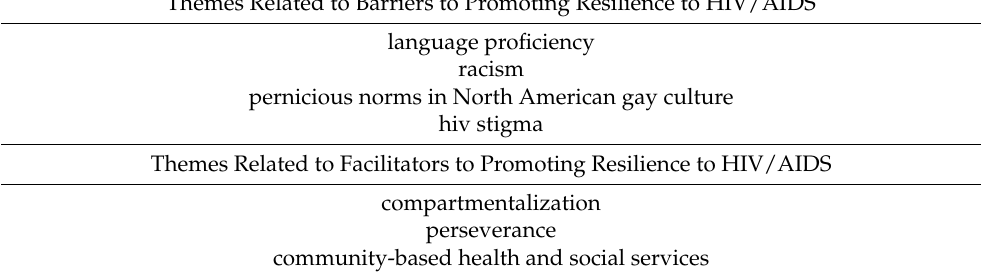
Table 3. Themes and